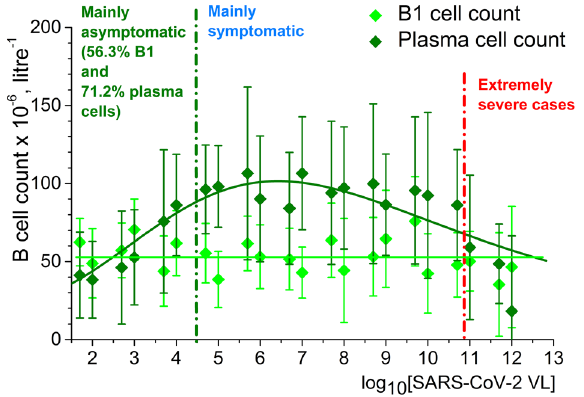
Figure 3. Correlation between B1 cell (light green line) and plasma cell (dark green line) counts in serum on logarithm of SARS-CoV-2 VL. Created in OriginPro ver. 9.2.196, https:// www. origi nlab. com.